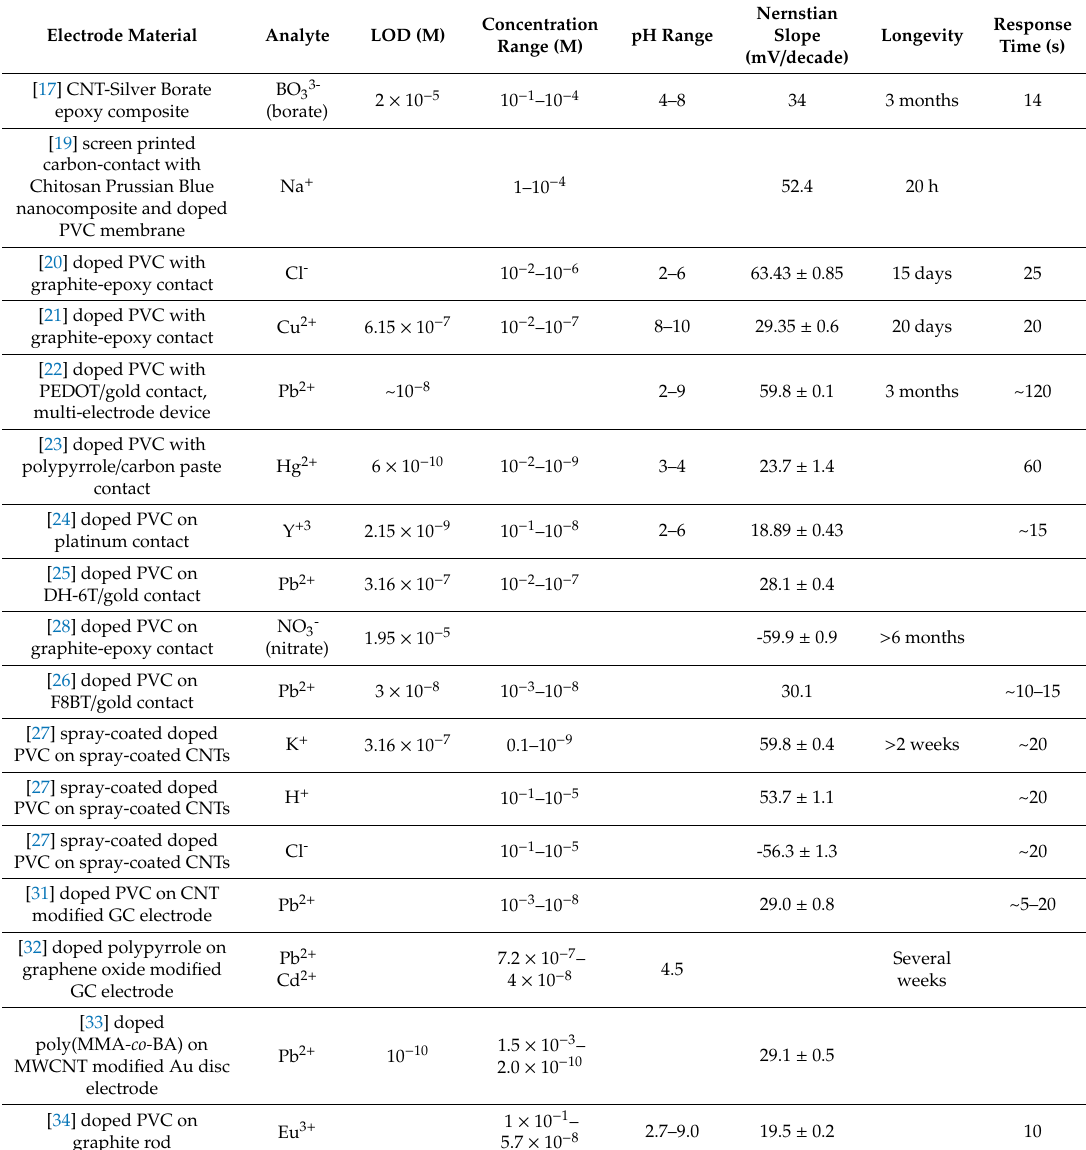
Table 1. Carrier-doped electrodes and their